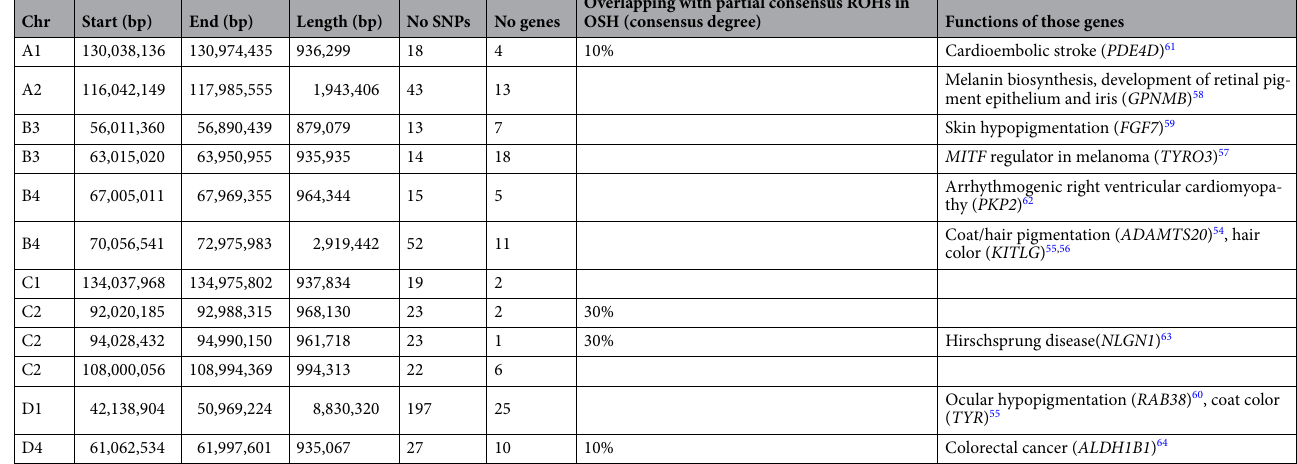
Table 8. Unique selective events identified by comparing OSH with SIAM using d i -summary statistics. For each of the selective events, the chromosomal location, the estimated region length, the consensus degree (%), the number of SNPs and the number of genes located in the event, as well as the functional annotation of those genes are